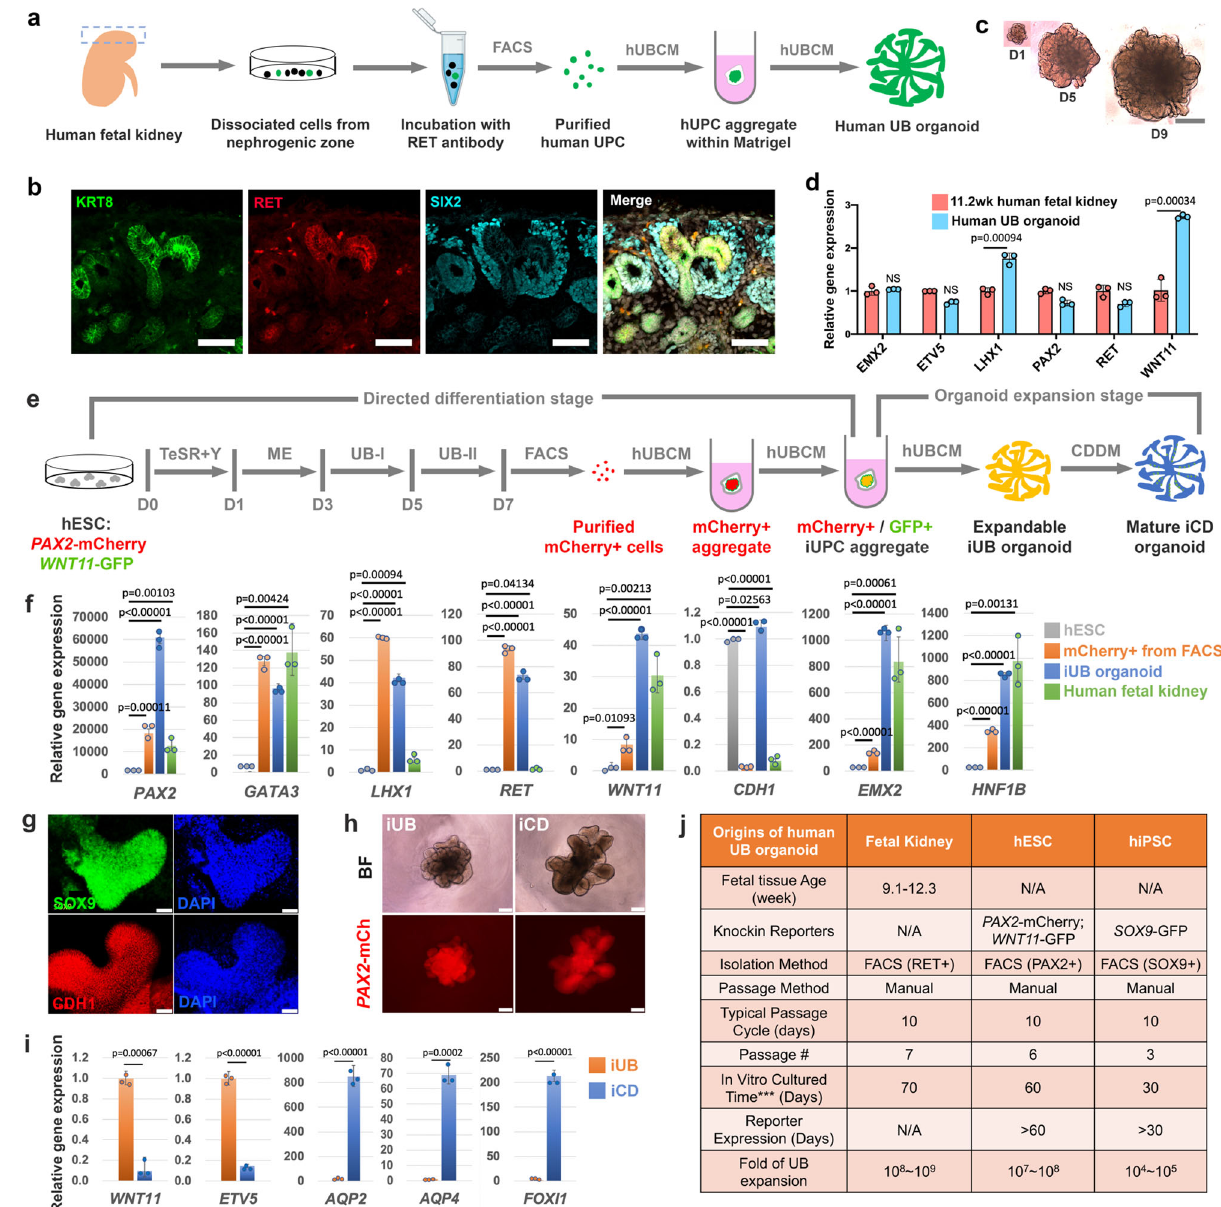
Fig. 4 Generating human UB and CD organoids from primary human UPCs and dual-reporter human pluripotent stem cells. a Schematic of the puri fi cation of primary human UPCs from the nephrogenic zone (illustrated as boxed region) of the human fetal kidney (9 – 13 weeks of gestational age) and the derivation of human UB organoid. b Immunostaining of the human fetal kidney nephrogenic zone for UB tip marker RET (red), broad UB lineage marker KRT8 (green), and NPC marker SIX2 (cyan). Scale bars, 50 µ m. c Time course bright fi eld images showing the growth of human UB organoid derived from primary human UPCs in a typical passage cycle at Days 1 (D1), 5 (D5), and 9 (D9). Scale bar, 200 µ m. All images in ( c ) have been scaled to share the same scale bar with the D9 image. d qRT-PCR analyses of human UB organoid (cultured for 54 days) derived from primary human UPCs for various UB markers as indicated. Human fetal kidney from 11.2-week (11.2 weeks) gestational age was used as control. e Schematic of the stepwise differentiation from WNT11 -GFP/ PAX2 -mCherry dual-reporter hESC line into iUB and iCD organoid. (TeSR mTeSR1 medium, Y Y27632, ME mesendoderm stage medium, UB-I UB Stage I medium, UB-II UB Stage II medium). f qRT-PCR analyses of the FACS puri fi ed mCherry + cells (orange) and the iUB organoid (blue, cultured for 50 days) for various UB markers as indicated. Undifferentiated H1 hESCs (gray) and human fetal kidney (green, 11.2-week gestational age) were used as controls. g Whole-mount immunostaining of the expandable iUB organoid for UB markers SOX9 and CDH1. Scale bars, 50 µ m. h Bright fi eld (BF) and PAX2 -mCherry ( PAX2 -mCh) images of expandable iUB organoid (left panels) and mature iCD organoid (right panels). Scale bars, 200 µ m. i qRT-PCR analyses of the iUB organoid (orange, cultured for 49 days) and iUB-derived iCD organoid (blue), for UB ( WNT11 , ETV5 ), PC ( AQP2, AQP4 ), and IC markers ( FOXI1 ). j Summary of human UB organoid derivation from different sources and their expansion in vitro. ***, this is the culture time we achieved before our lab shutdown due to coronavirus outbreak. The maximum organoid culture time and expansion could be much greater. All data are presented as mean ± s.d. In d , f , i , the signi fi cance was determined by two-tailed unpaired Student ’ s t tests; NS not signi fi cant; n = 3. Source data are provided as a Source Data fi le.